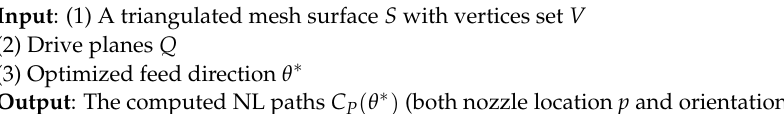
Algorithm 2 Efficiency optimized iso-planar printing path generation